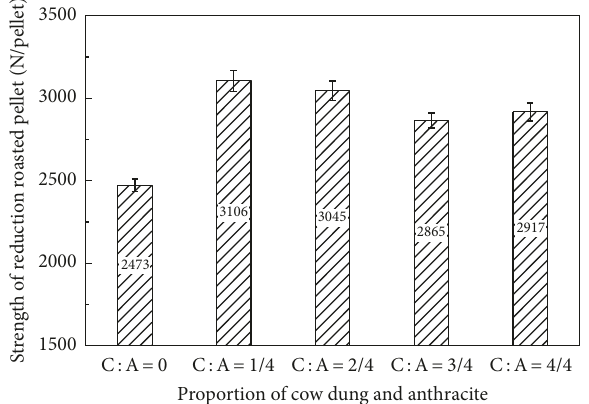
Figure 5: Strength of different carbon-bearing pellets after reduc- tion roasting at 1523